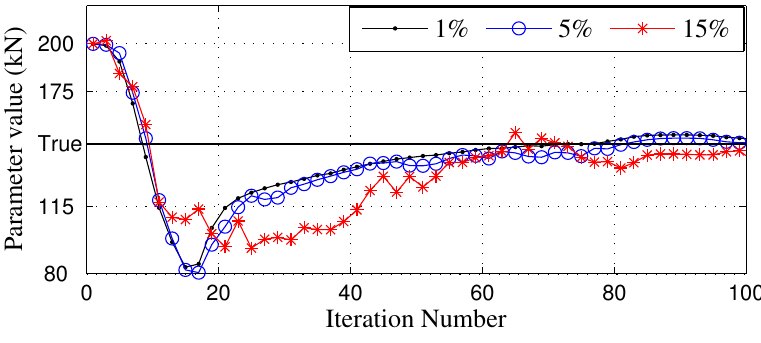
Figure 12. Convergence of the no-load parameter, ϕ 1 , for different measurement noise